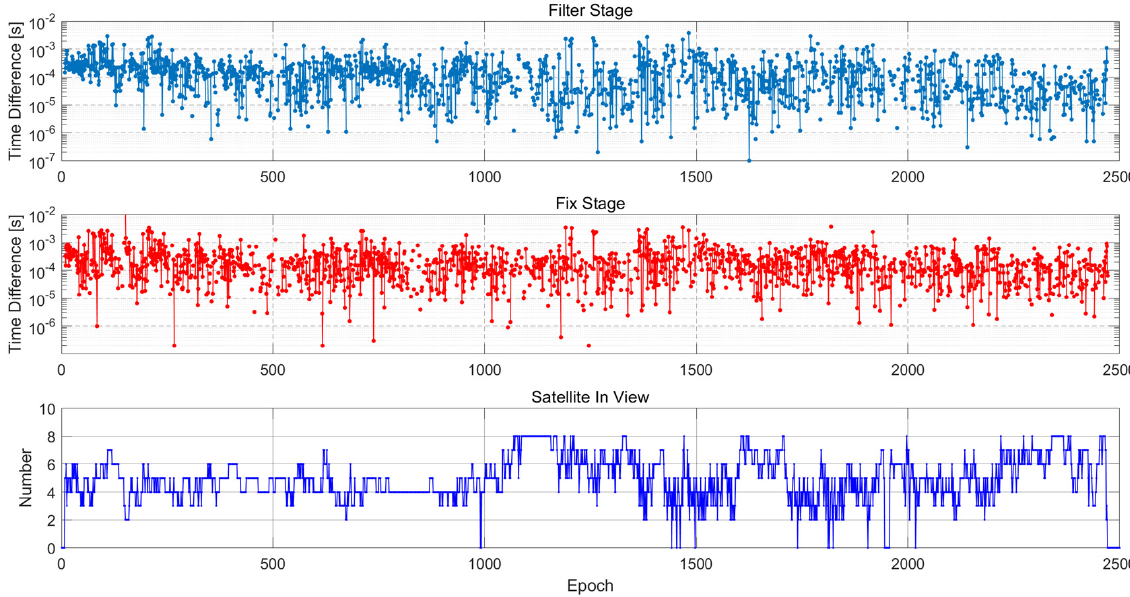
Figure 14. Filter and fix time difference and the corresponding satellite number.